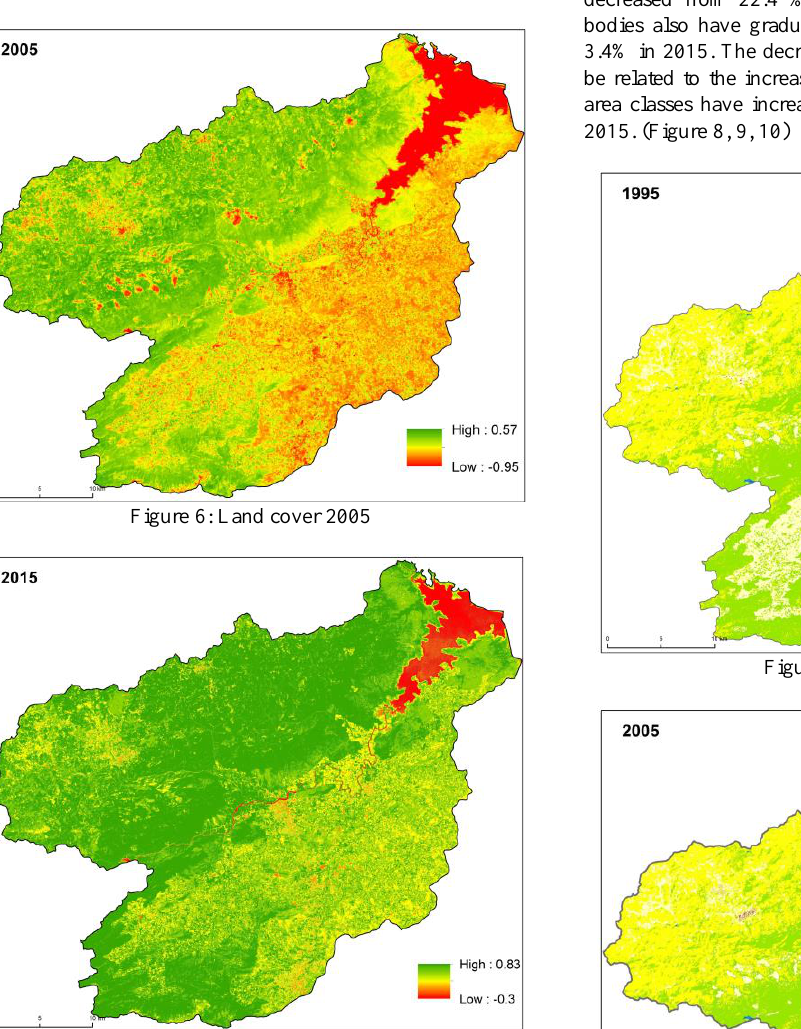
Figure 5: Land cover 1995